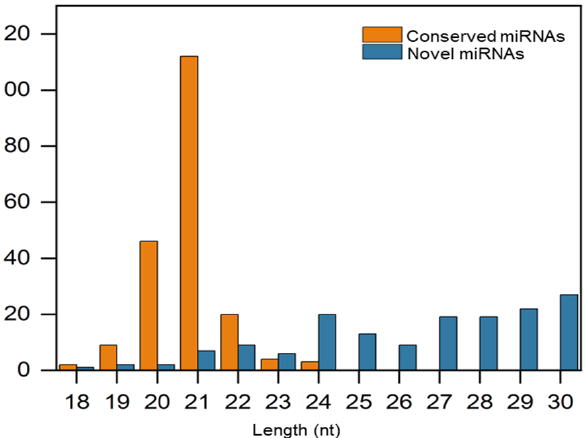
Figure 2. Length based distribution of conserved and novel miRNAs in olive roots.